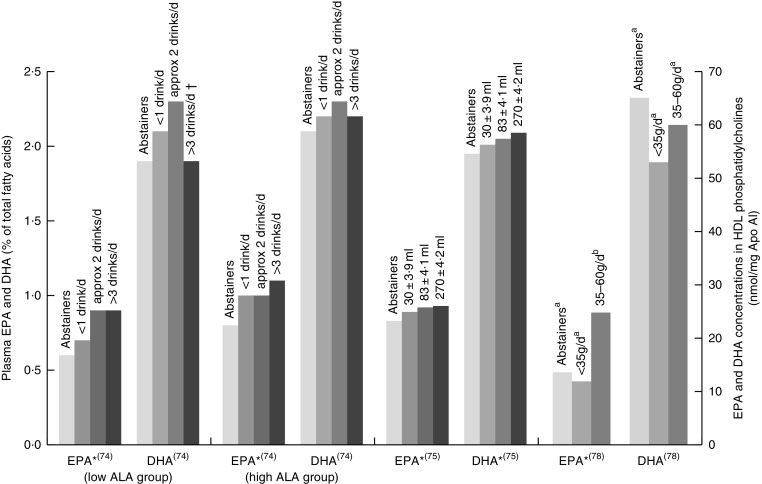
EPA and DHA levels in alcohol abstainers v. wine drinkers. Bar graph presents plasma EPA and DHA (percentage of total fatty acids) for de Lorgeril(

74

) and di Giuseppe(

75

) studies and EPA and DHA concentration in HDL phosphatidylcholines for the Perret study(

78

). *P<0·05. †DHA intake was approximately 3× lower in subjects who drank >3 drinks per d compared with other subjects. a,bBars in the same study with unlike letters have significantly different fatty acid levels. ALA, α-linolenic acid.